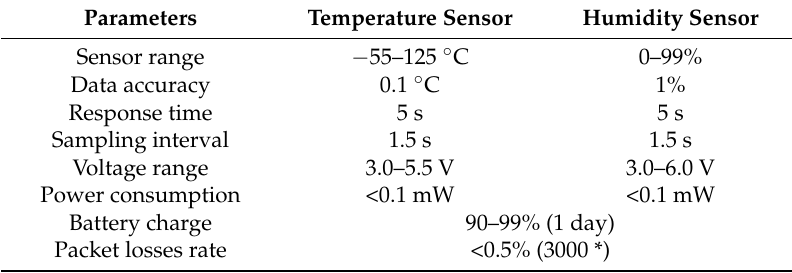
Figure 3. Physical implementation of the sensor node hardware. Table 1. Performance parameters of the wireless sensor network (WSN).